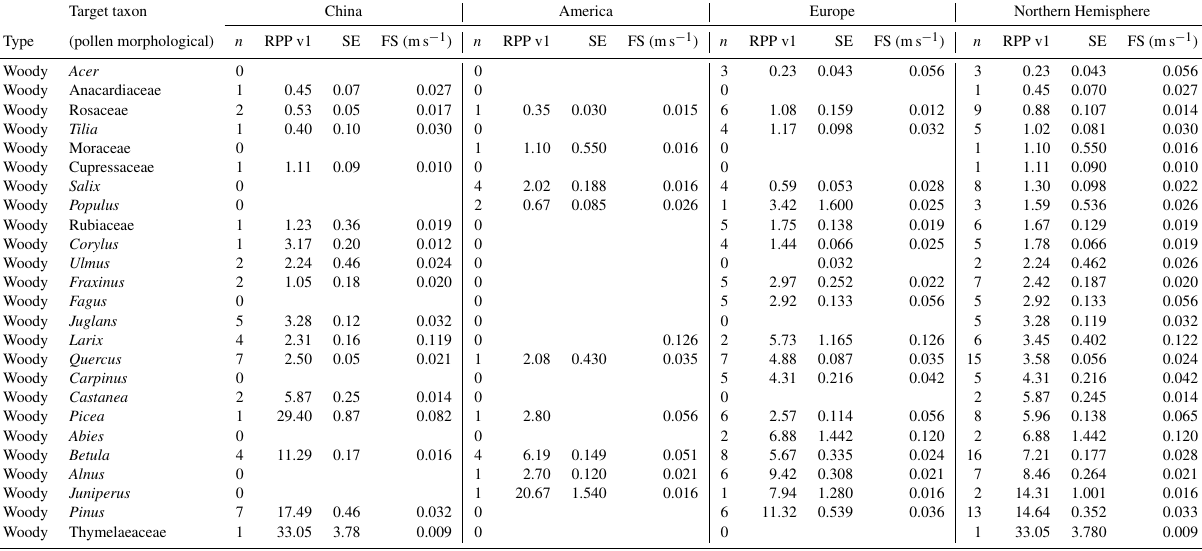
Table 3. Overview of continental and northern hemispheric relative pollen productivity (RPP) estimates for woody vegetation with their standard error (SE) (dataset v1) and fall speeds. All values are relative to Poaceae. See Table A1 for information on original RPP data, Table A4 for information on original fall speed values, and methods on the creation of dataset v1 (Wieczorek and Herzschuh, 2020, https: //doi.org/10.1594/PANGAEA.922661).